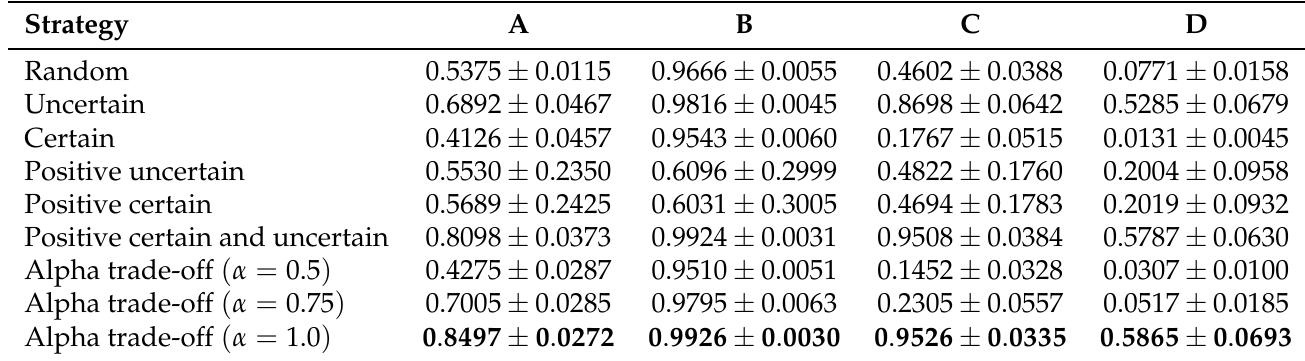
Table 10. Mean recall score with standard deviation, aggregated over used models and representations, for each strategy, reported on each of the four datasets. The best score for each dataset is shown in bold. A–D correspond to the four datasets we used to conduct the experiments, which are described in Table 2.